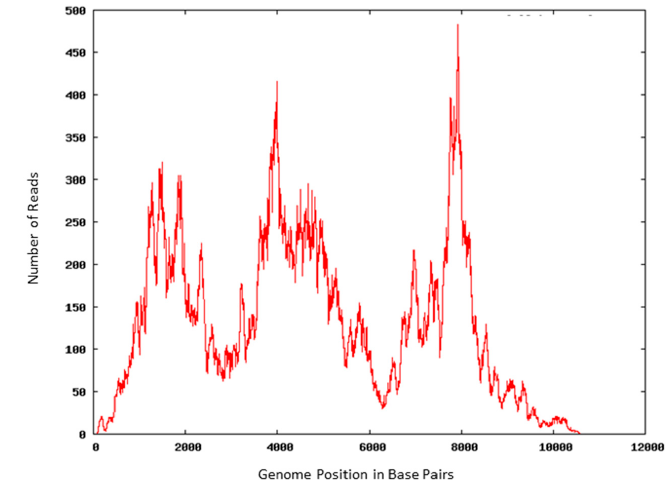
Figure 2. Coverage plot for the Dengue-2 virus genome from the HiSeq reads that mapped to the genome. The differences in coverage between different areas of the genome are probably related to RNA folding, bias in library preparation, or GC content [35], but we cannot rule out the hypothesis that the areas of reduced coverage are due to photoadduct formation after 4 1 -aminomethyl-trioxsalen (AMT)+UV-A